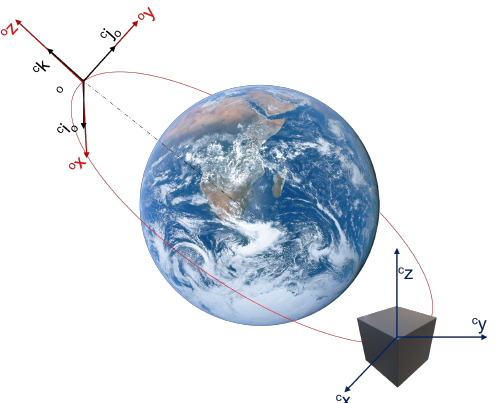
Figure 1. The coordinate system can be visualized in this figure. BCS is centered on the spacecraft’s body (represented by the blue CS centered on the black cube’s center of mass). OCS is fixed on the orbit (represented by the red CS fixed on the red orbit), and the unit vectors c i o , c j o and c k o are aligned with the OCS (represented by the black CS). The unit vector c i o is pointing in the direction of orbital angular velocity vector (therefore, orthogonal to orbital plane), and the unit vector c k o is pointing away from the center of the earth (shown by dotted